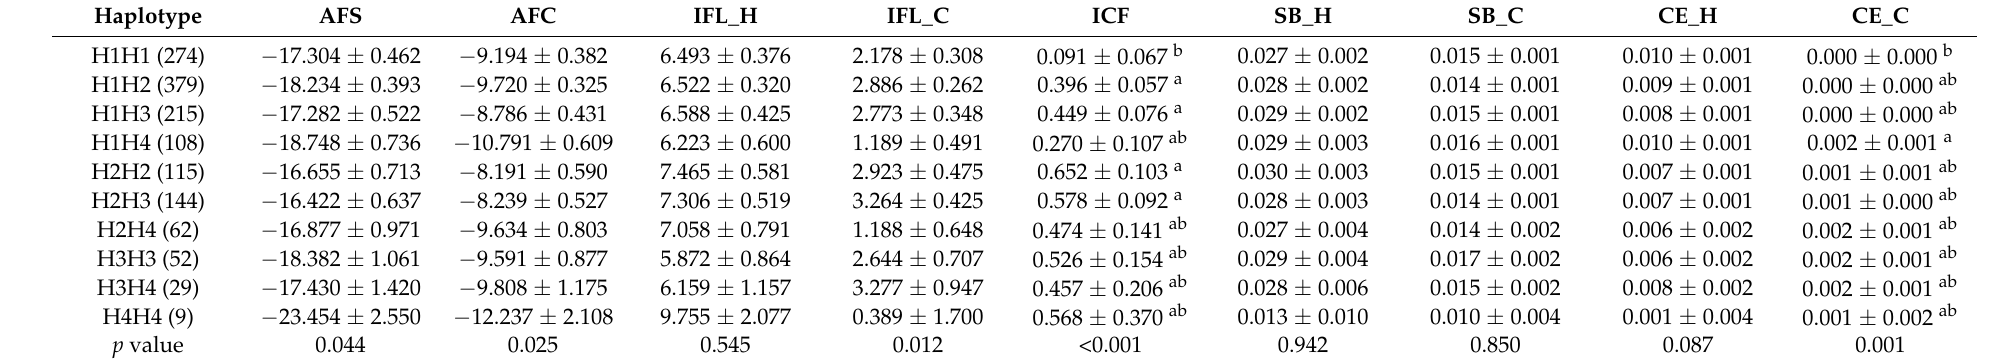
Table 3. Association of haplotype block within gene LEPR with reproductive traits in Holstein cows (least square mean ± standard